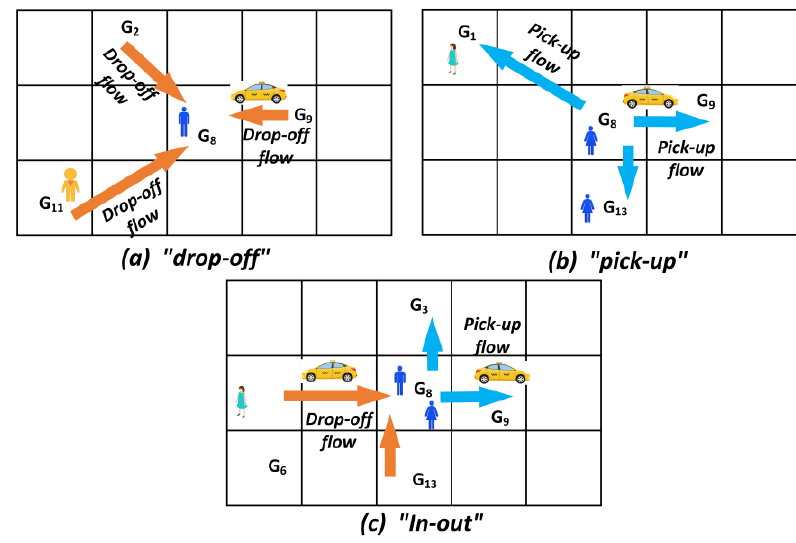
Figure 4. The three crowd flows in the city geogrid.